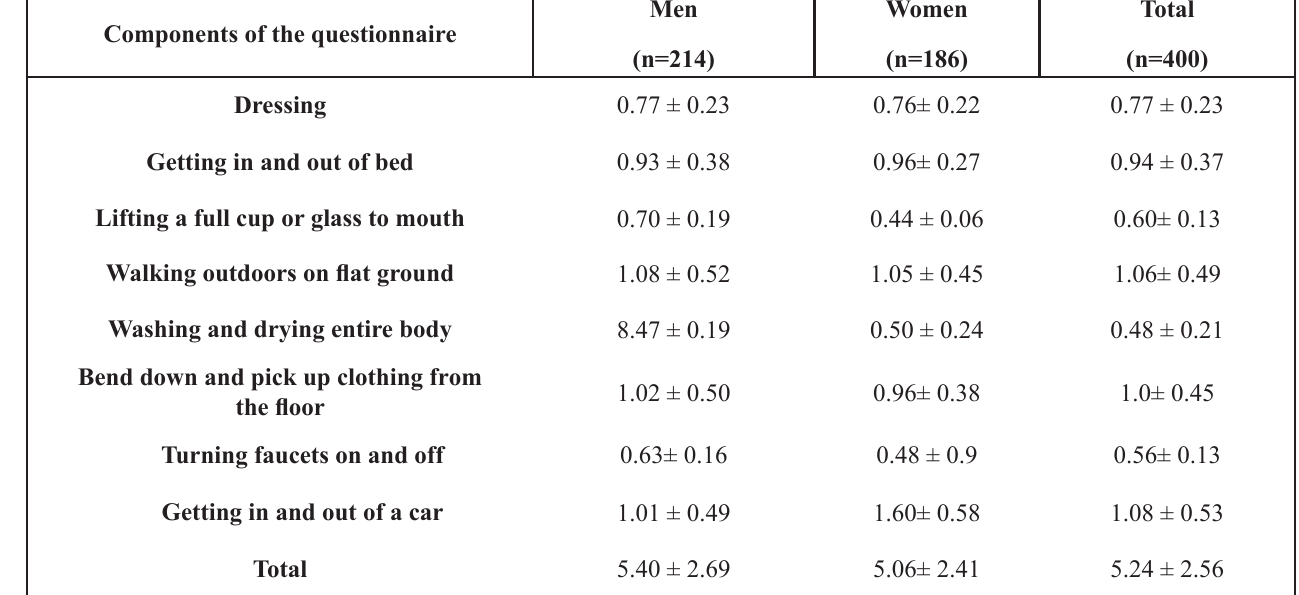
Table 2. Scores of the components of the questionnaire. Data are presented as